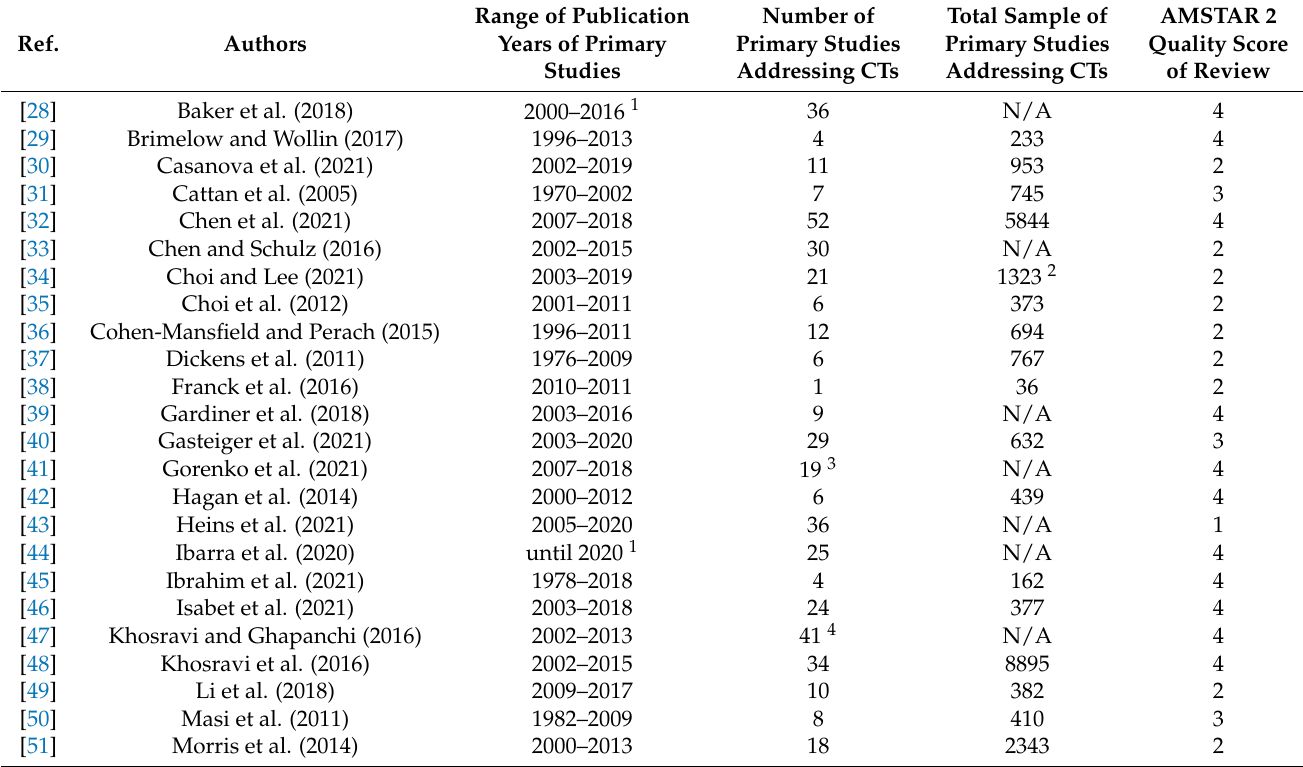
Table 1. Description of Included Reviews Addressing the Impact of CTs on Loneliness and Social Isolation Among Older